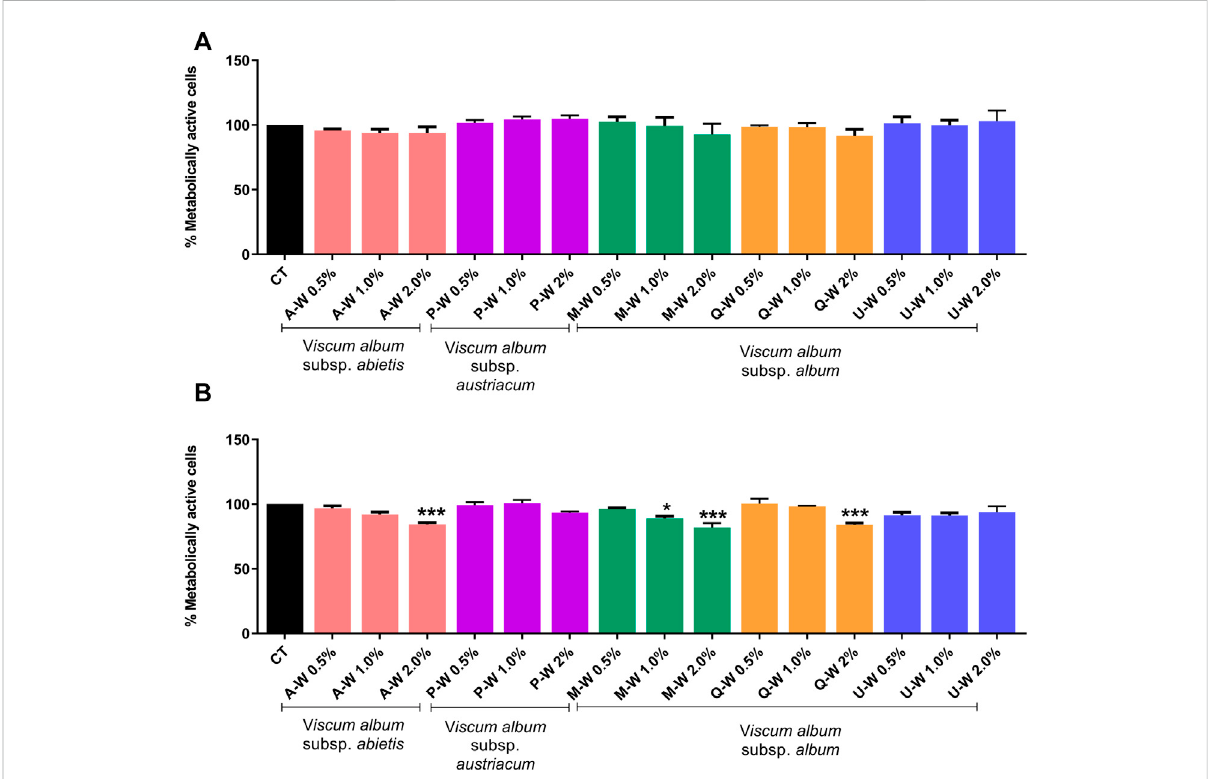
FIGURE 3 Dose-responseeffectof V.album mothertincturesontheproliferationofMDA-MB-31celllineassessedbyMTT. (A) MDA-MB-231winter-dose response effects after 24 h of treatment with MTs. (B) MDA-MB-231 winter-dose response effects after 48 h of treatment with MTs. The fi nal MTs concentrations tested were: 0.5; 1.0; 2.0% v/v. The results are expressed as the mean ± standard error from three independent experiments done in triplicate, in relation to control cells (untreated and treated with ethanol). * p < 0.05; *** p < 0.0001 obtained with one-way ANOVA/Dunnet ’ s posthoctest.Legendsymbols:(CT)controluntreatedcells; V.album subsp. album growingon Malusdomestica (M – W), Quercuspetraea (Q – W)and Ulmus carpinifolia (U – W); V. album subsp. abietis growing on Abies alba (A – W); and V. album subsp. austriacum growing on Pinus sylvestris (P – W). Samples were harvested in winter (W) season.